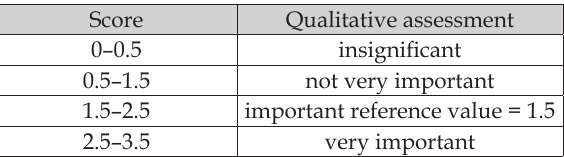
Table 3. Rating scale.